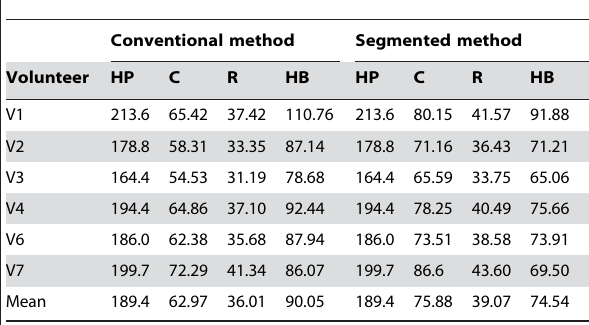
Table 8. Estimates of heat production, convective heat loss, radiant heat loss and heat balance using the conventional method and the segmented method when Ta is 30 u C.